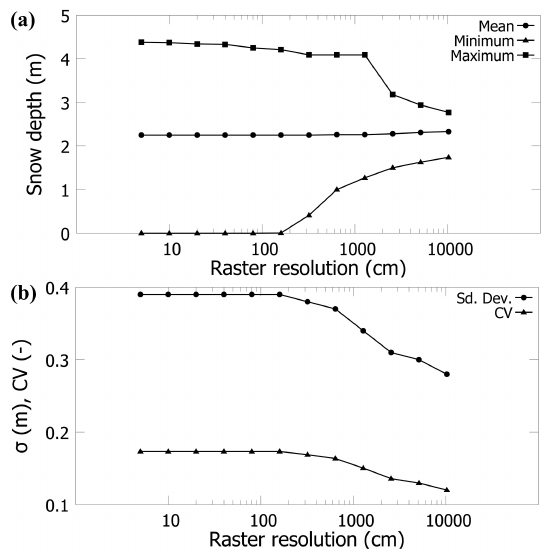
Figure 9. Snow depth statistics within the study domain as a func- tion of map cell size. (a) Minimum, mean, and maximum snow depth; (b) snow depth standard deviation ( σ ) and coefficient of vari- ation